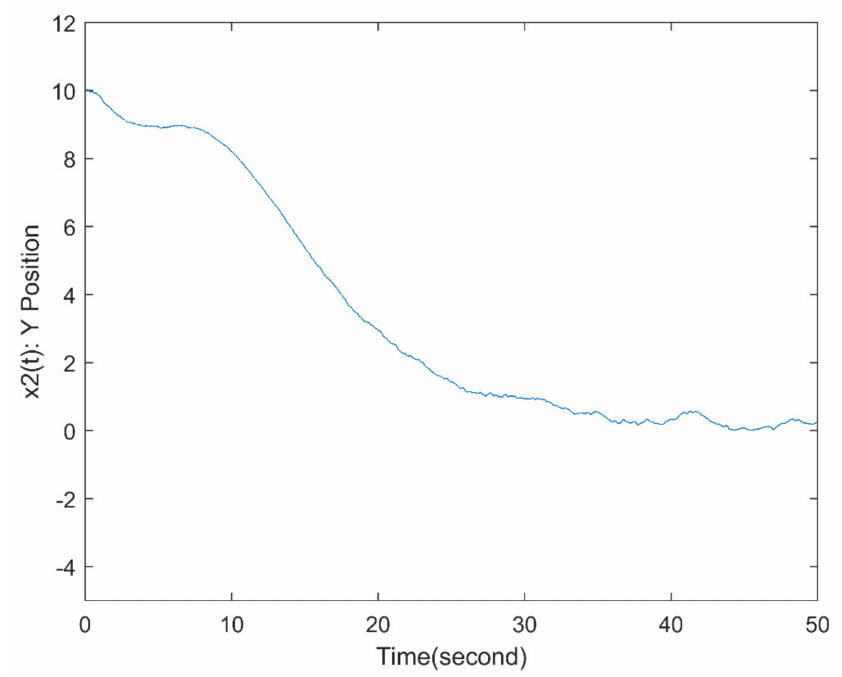
Figure 3. Response of state x 2 ( t )